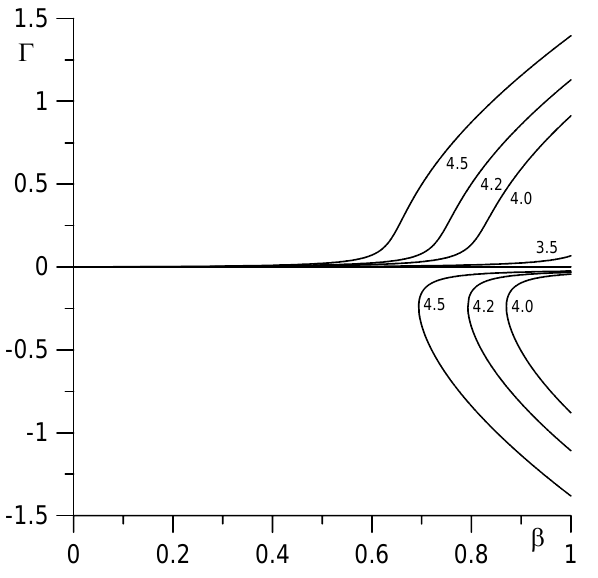
Fig. 5a. Spectrum of flute modes for δ = 0 . 01 (local noon).